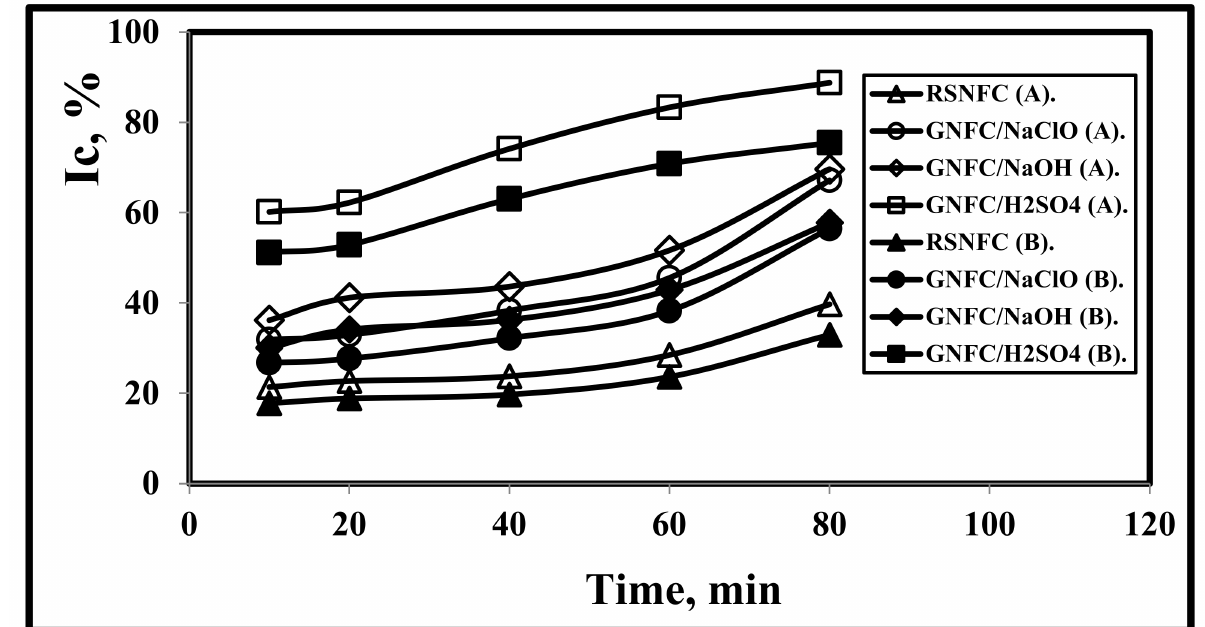
Figure 6. Effect of reaction time on the crystallinity of RSNFC, GNFC/5%NaClO, GNFC/5%NaOH, and GNFC/5%H 2 SO 4 using both method A and method B.